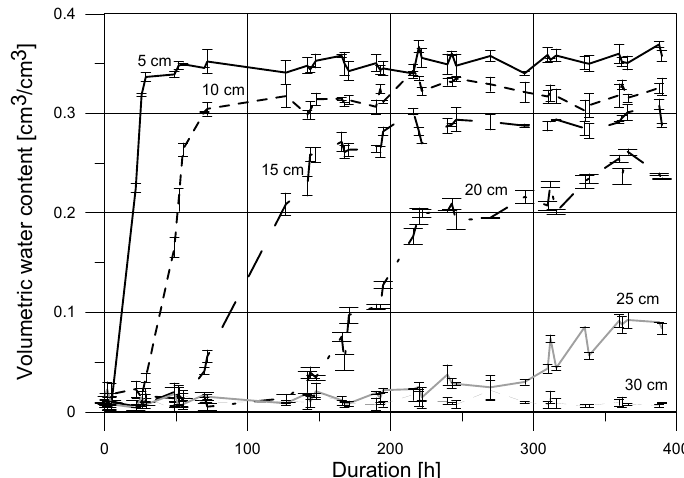
Figure 7. Combined standard and expanded measurements uncertainties of the TDR surface sensor for aerated concrete.